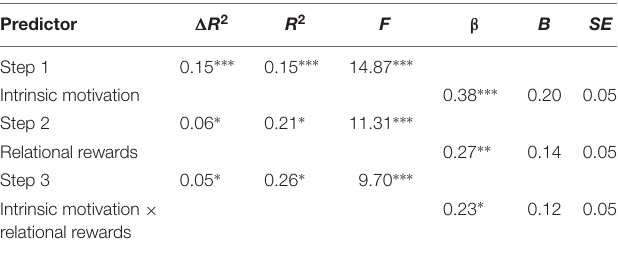
TABLE 6 | Hierarchical regression analysis predicting creativity/innovation from intrinsic motivation and relational rewards.